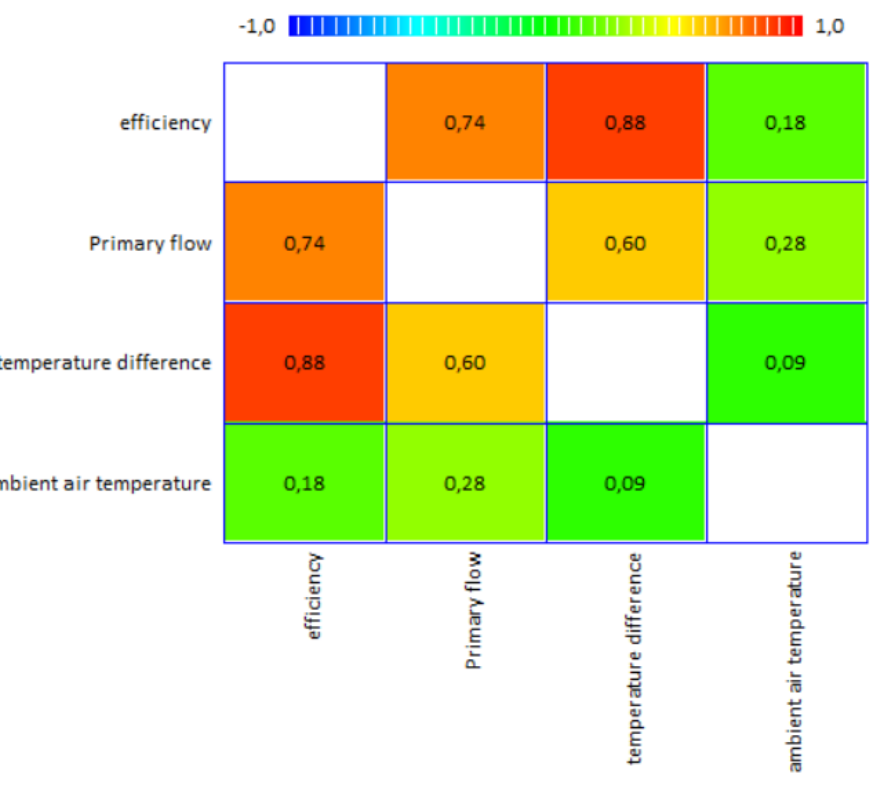
Figure 8. Correlation plot.